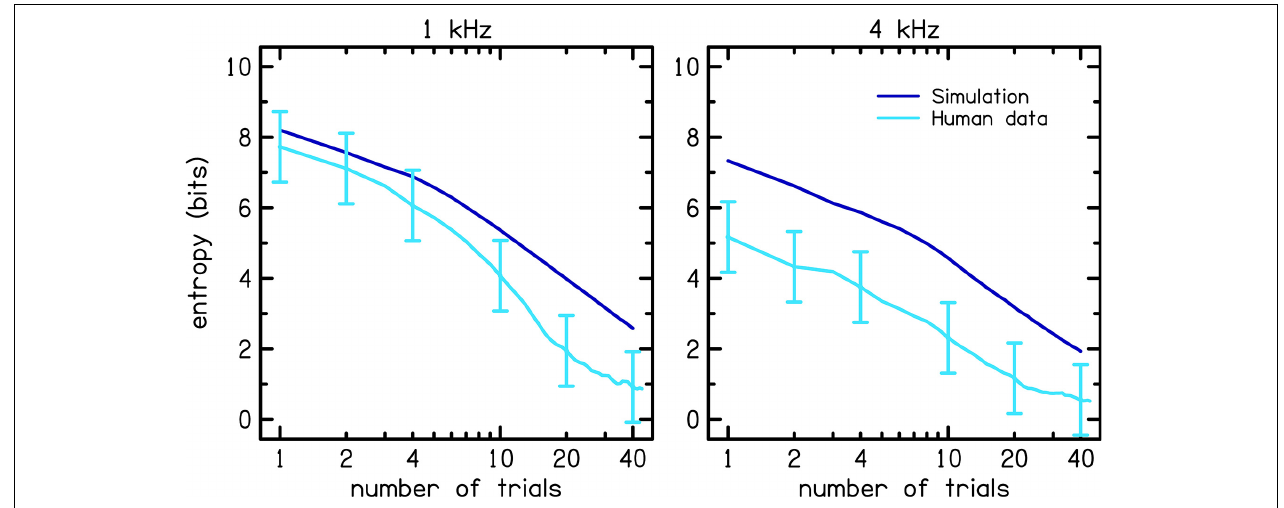
FIGURE 9 | Comparison of the entropy between the simulation (dark blue) and human data (light blue). Error bars for the human data represent one standard deviation from the mean.